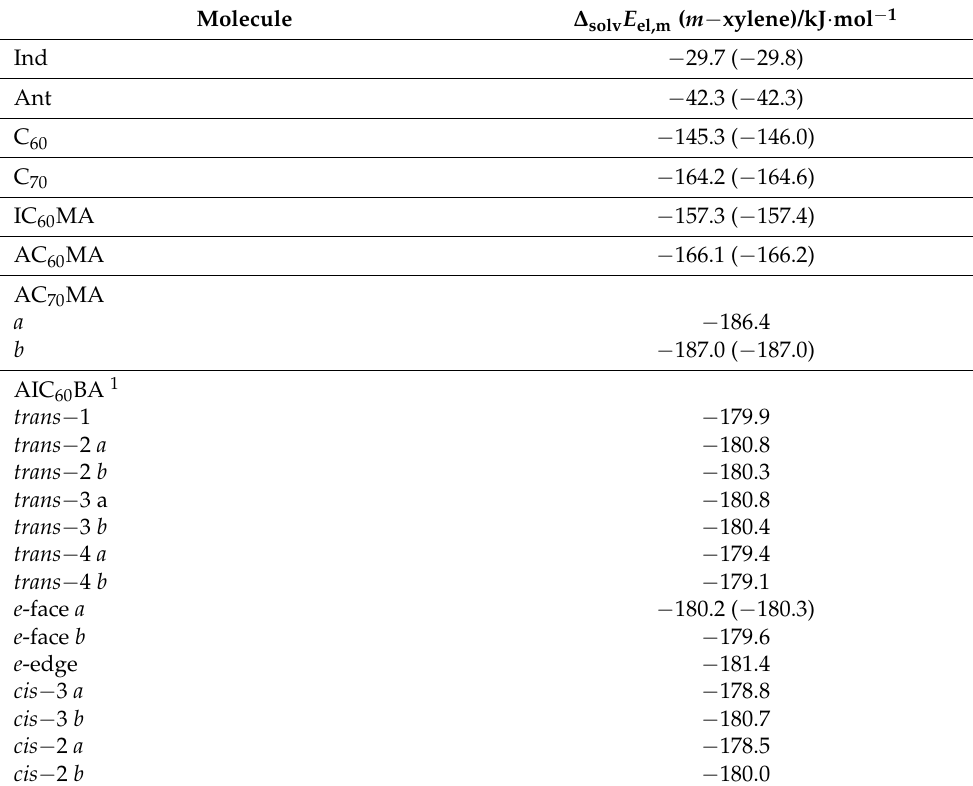
Table 3. Electronic energies of solvation in m − xylene, at T = 0 K, for the compounds involved in the Diels − Alder cycloadditions of the fullerenes studied, calculated as M06-2X/6-31+G(d)single- point energy calculations on the M06-2X/6-31+G(d) optimized geometries in vacuum and